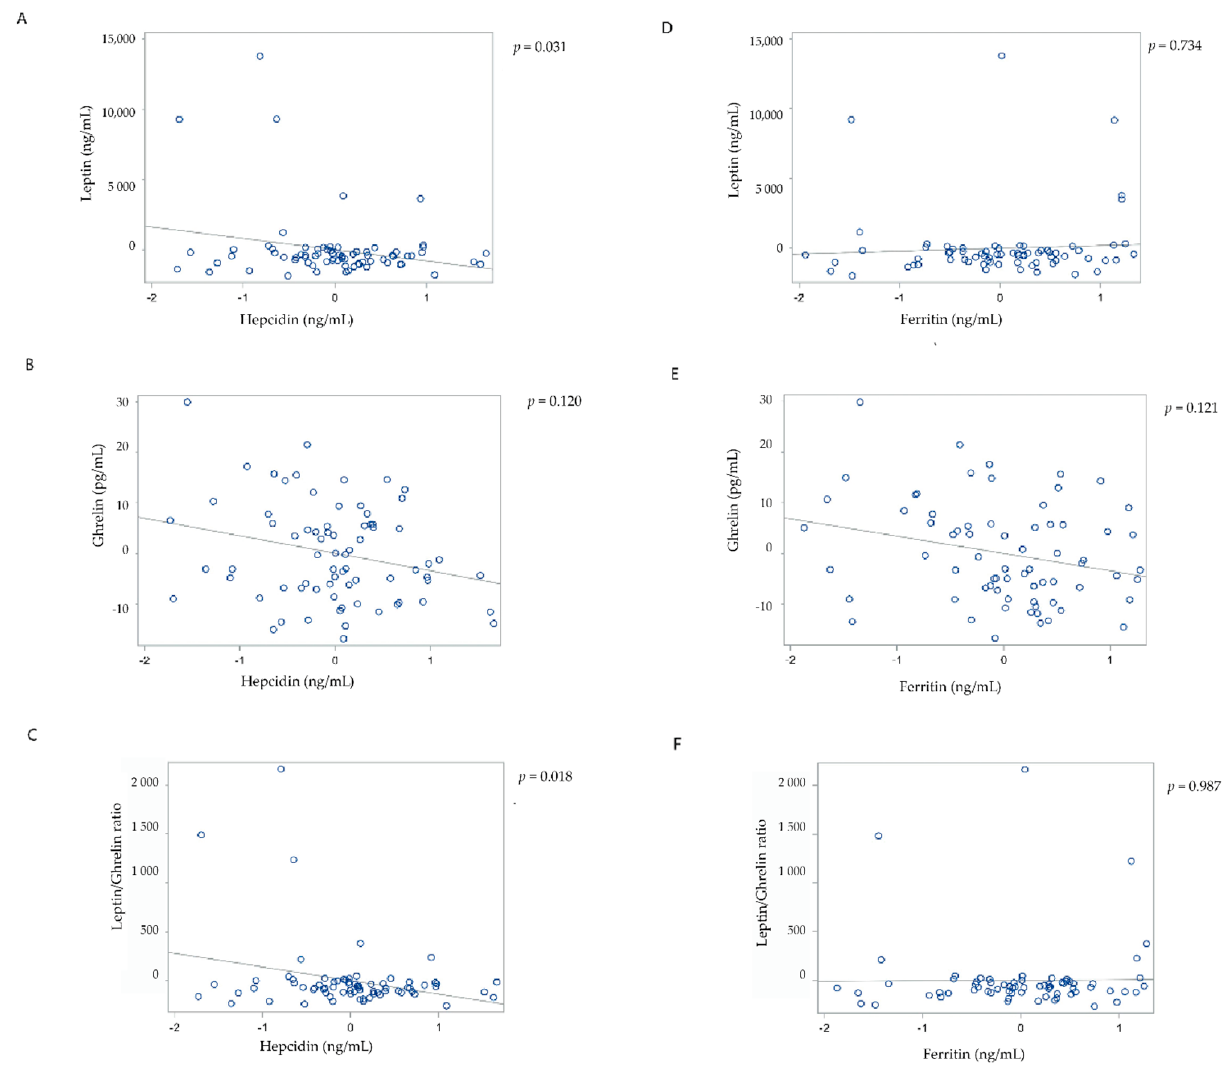
Figure 1. Associations between hepcidin and leptin ( A ), ghrelin ( B ), and the leptin/ghrelin ratio ( C ); and ferritin and leptin ( D ), ghrelin ( E ), and the leptin/ghrelin ratio ( F ) in the fasted state. All partial residual plots were adjusted for age, sex, body mass index, use of antidiabetic medications, aetiology of pancreatitis, and recurrence of pancreatitis. Hepcidin and ferritin data were transformed using natural logarithm transformation.